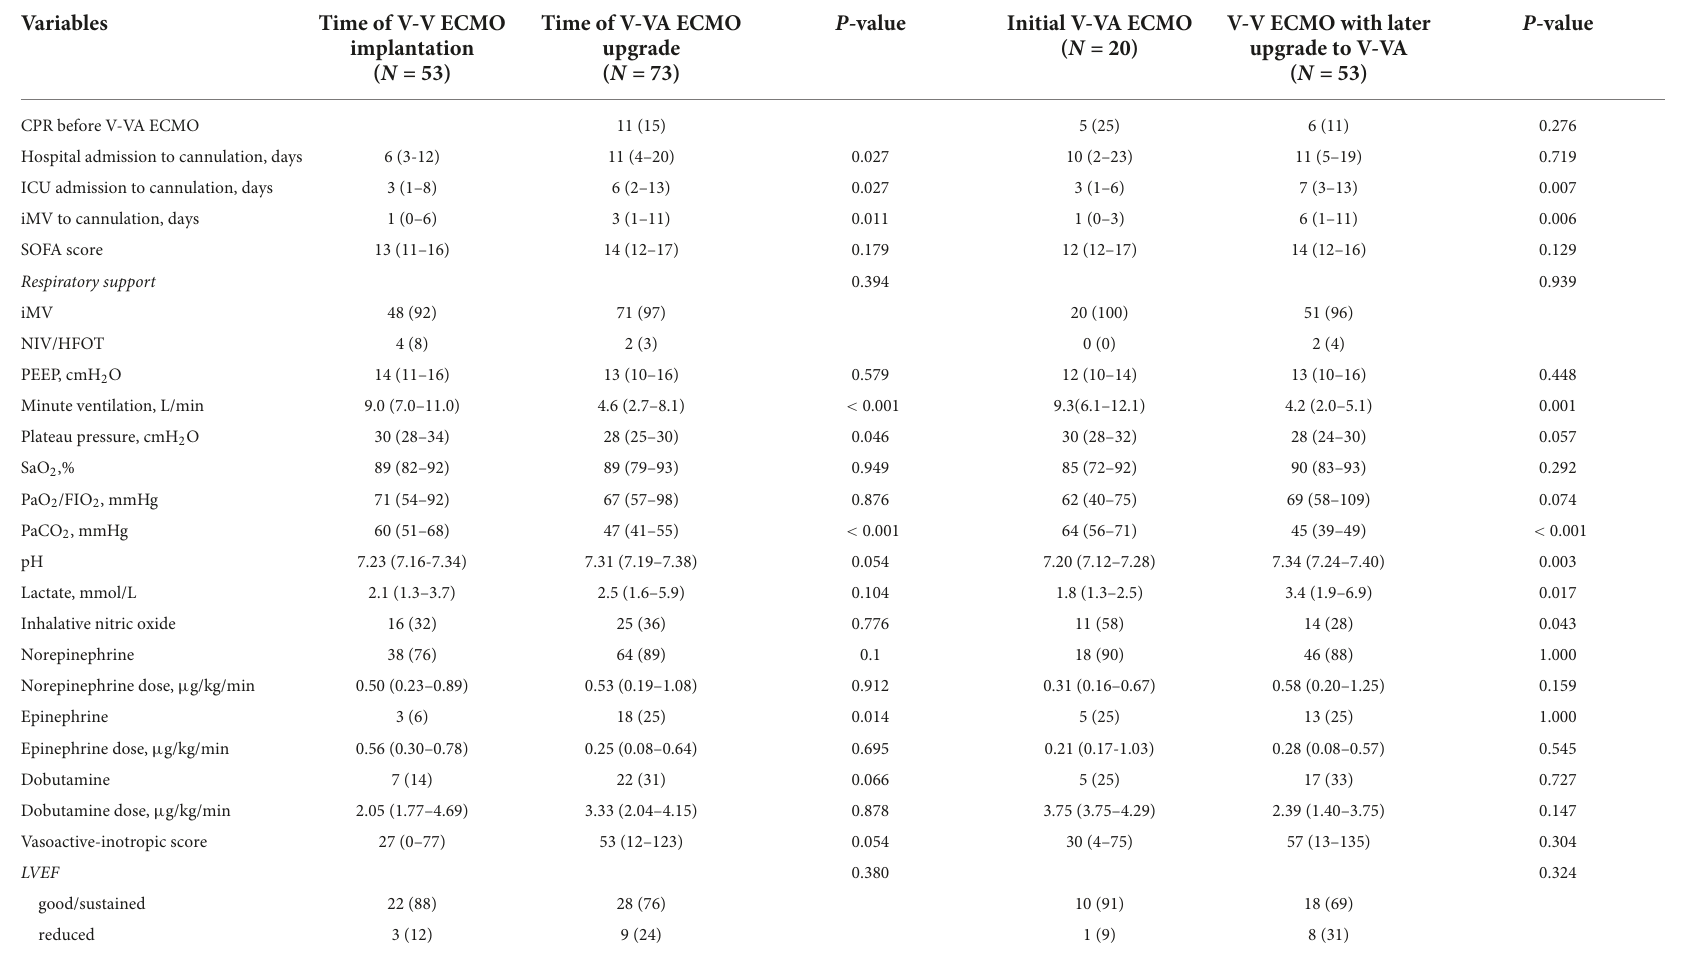
TABLE 2 Clinical condition and organ